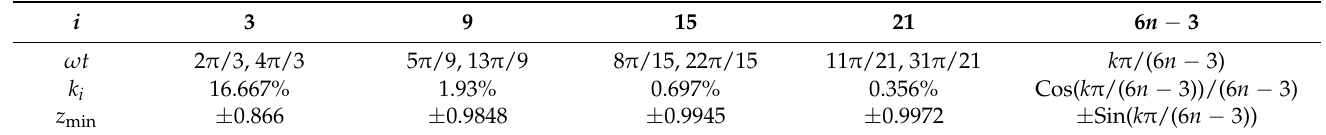
Table 1. Results for different i values.